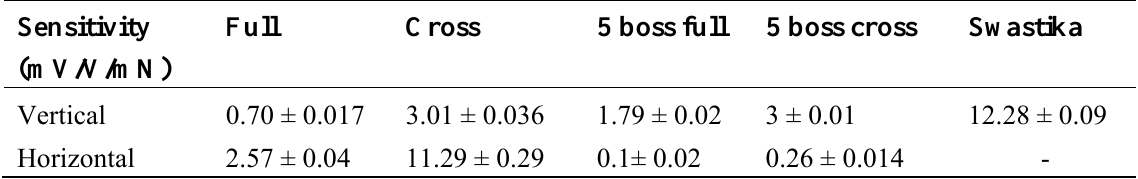
Table 3 . Summary of sensitivity in horizontal and vertical direction for all five designs.